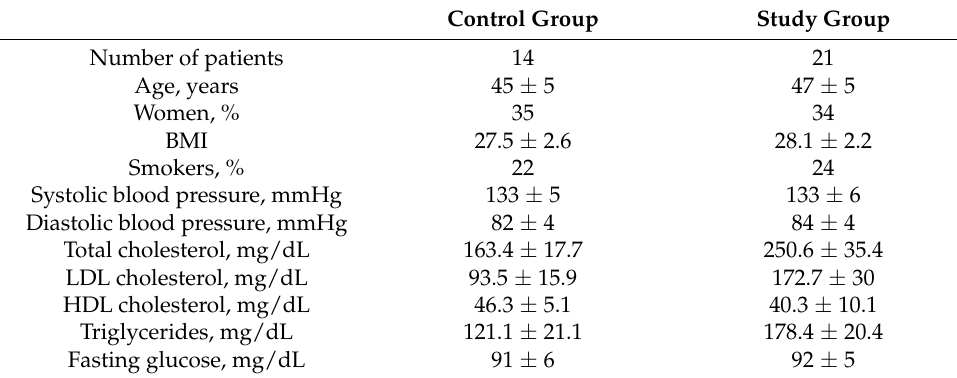
Table 1. Baseline characteristics of patients (values are mean ± standard deviation (SD) unless indicated otherwise). Control Group Study Group Number of patients 14 21 Age, years